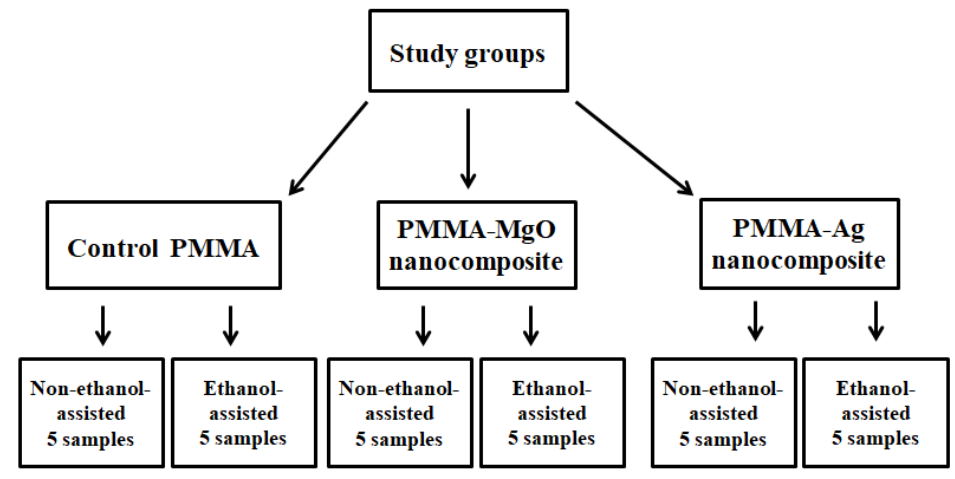
Figure 1. Study design and groups.